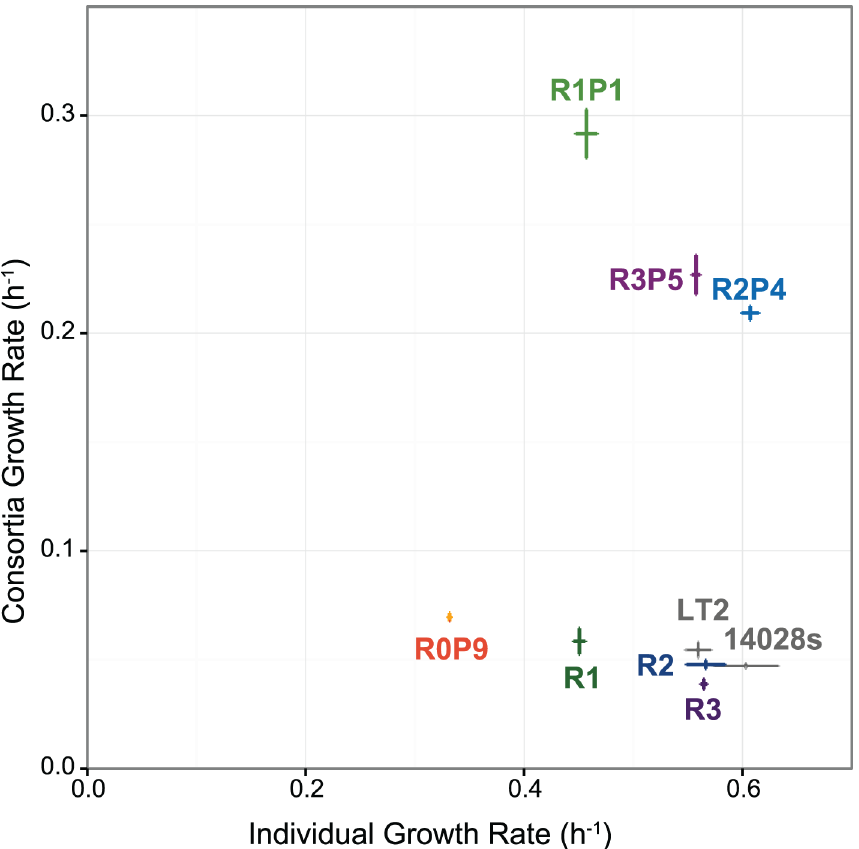
Fig 5. Individual and consortia growth rates for wild-type, ethionine resistant, and evolved strains. Individual growth of S . enterica strains was measured in galactoseminimalmedia, while consortiagrowth rates represents S . enterica strains co-cultured with E . coli Δ metB in lactose minimalmedia. S . enterica LT2 is the wild-typeancestor of R1, which evolvedinto R1P1. S . enterica 14028sis the wild-typeancestor of R2 and R3, which each evolvedinto R2P4 and R3P5, respectively.Error bars represent standarderror of three biological